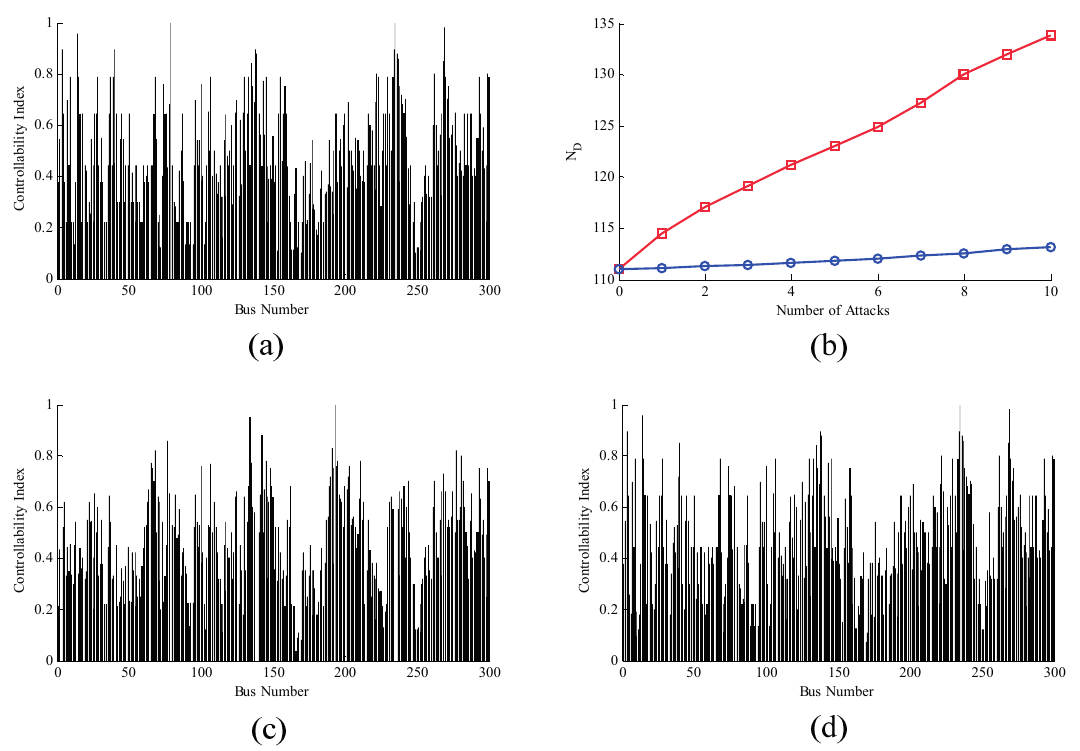
Figure 8. Identification results of the IEEE 300 bus system. ( a ) Initial controllability index distribution; ( b ) Increase in N D of the network after arracks; ( c ) Controllability index distribution after ten targeted attacks. ( d ) Controllability index distribution after ten random